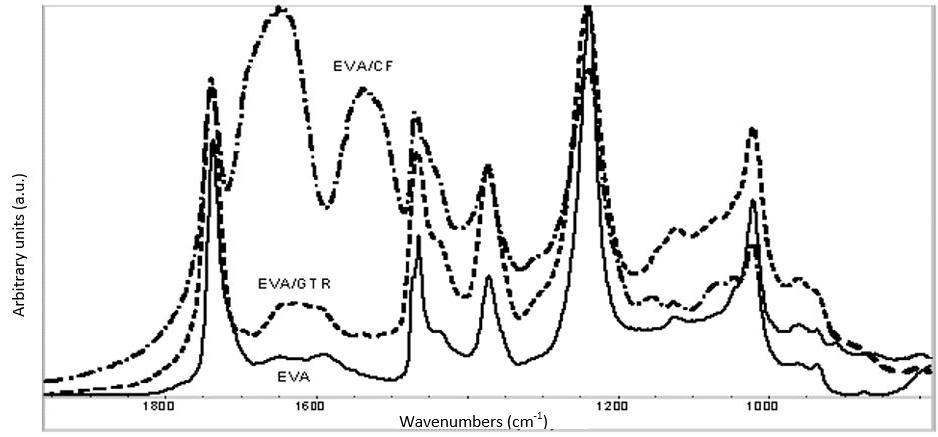
Figure 6. FTIR spectra of EVA matrix and composites EVA/GTR40 and EVA/CFs40.